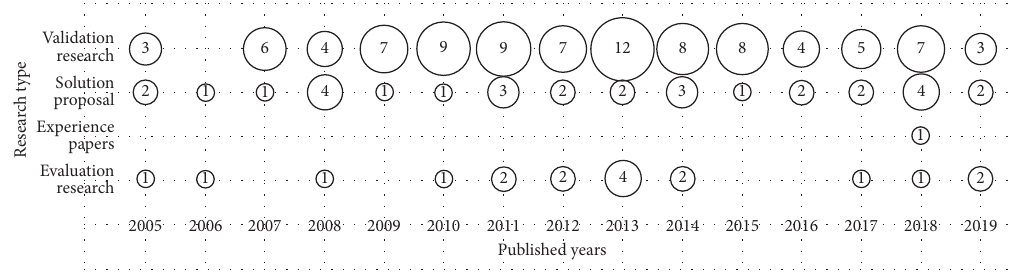
Figure 5: The number of research types per